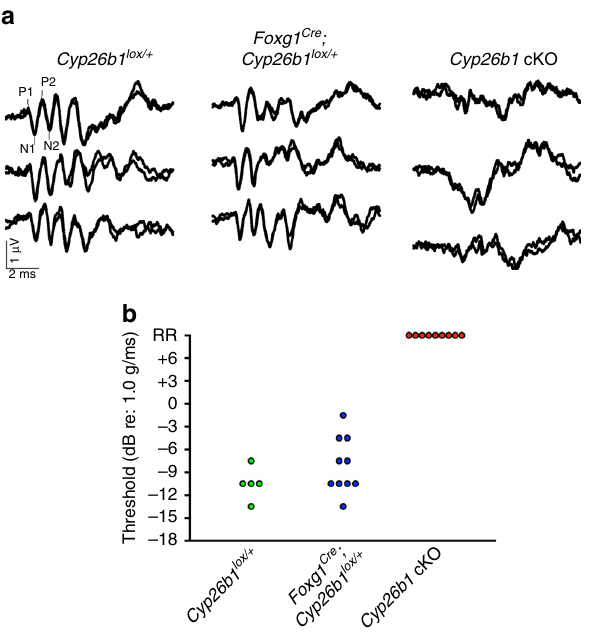
Fig. 6 Absence of linear vestibular-evoked potential (VsEP) in Cyp26b1 cKO mice. a Three representative VsEP waveforms for each genotype recorded at maximal jerk stimulus ( + 6 dB). In the Cyp26b1 cKO mutants, distinct peaks of P1 – P2 and N1 – N2 are not detectable. b Summary of thresholds for VsEP determined by various jerk magnitudes. There was no signi fi cant difference in VsEP thresholds between the Cyp26b1 lox/ + ( − 10.5 ± 1.34 dB re: 1 g/ms, n = 5) and Foxg1 Cre ;Cyp26b1 lox/ + heterozygotes ( − 8.1 ± 1.17 dB re: 1 g/ms; n = 10, P = 0.1026, unpaired t test). Cyp26b1 cKO mutants generated only a remnant response